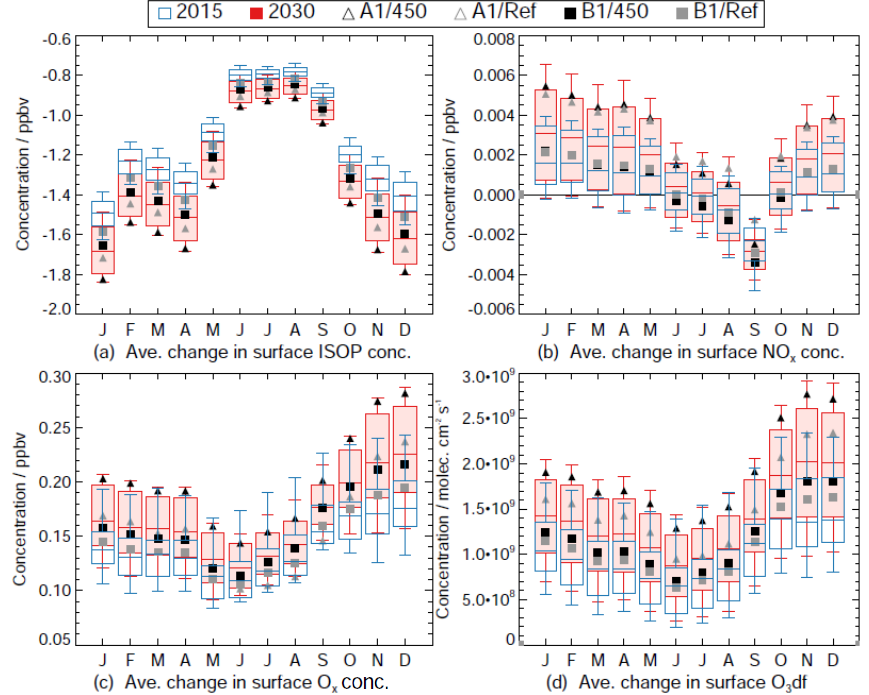
Fig. 8. Same as Fig. 7 but for Brazil (Fig.